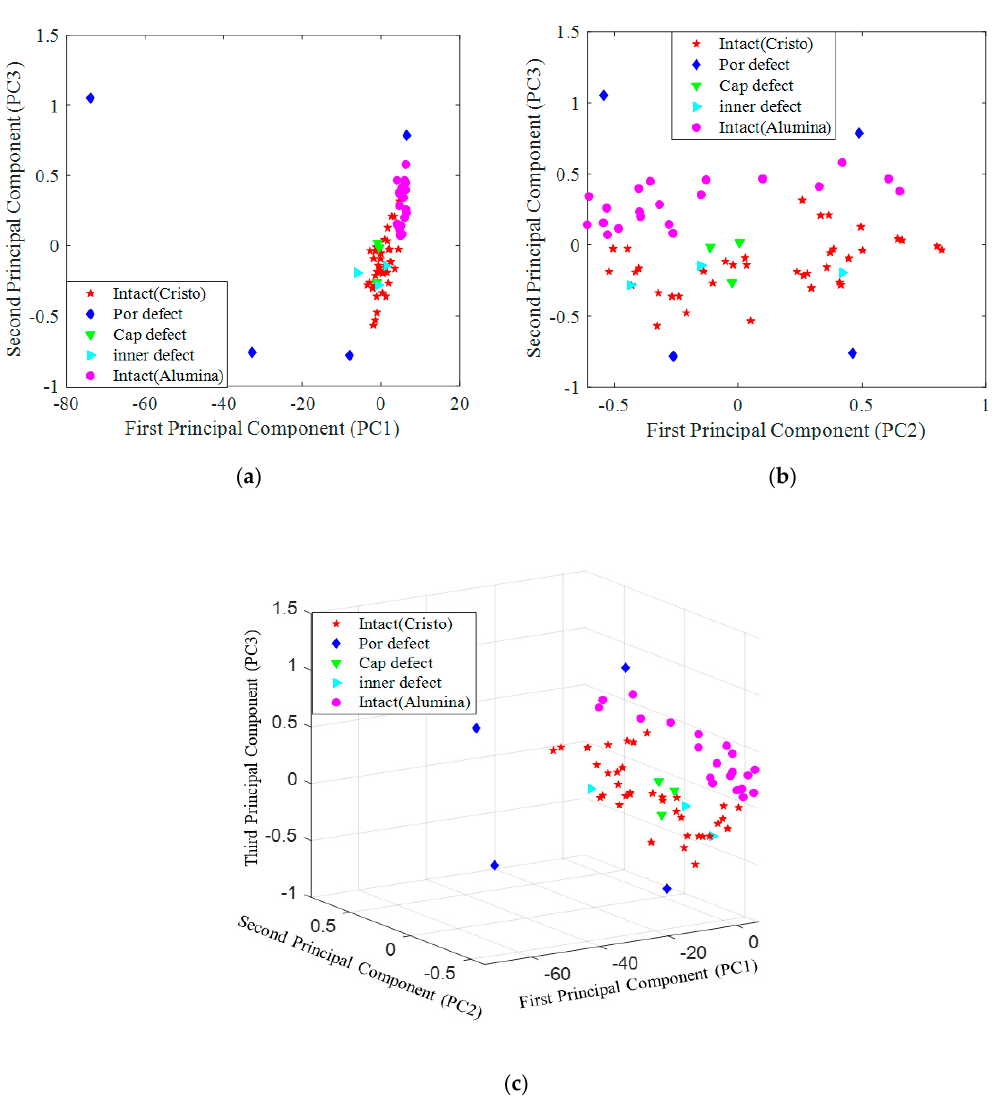
Figure 11. 2D and 3D plots using two and three eigenvectors extracted from time data. ( a ) 2D plot using PC1 an PC3; ( b ) 2D plot using PC2 and PC3; ( c ) 3D plot using largest PC1, PC2, and PC3